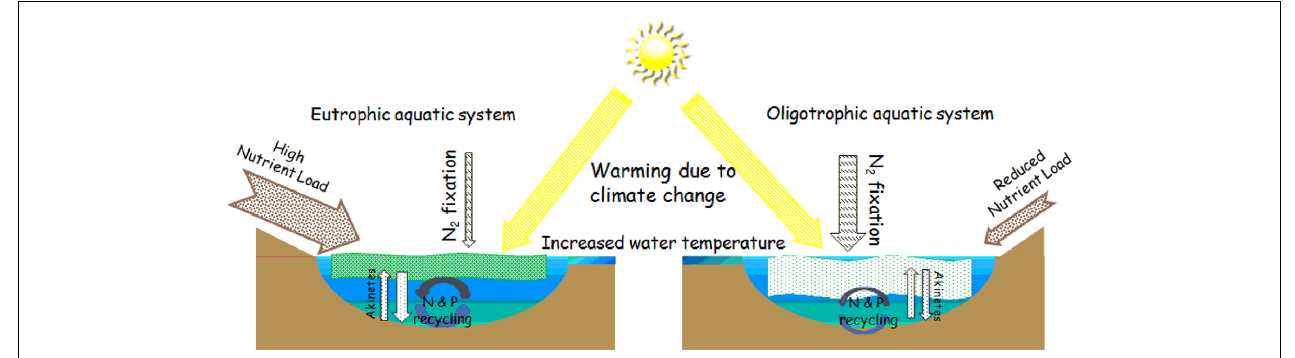
formation and N 2 fixation and is controlled by restricted external and internal P load (narrow arrows). Dormant cells, akinetes, are formed in both cases (more akinetes are expected in eutrophic systems due to high biomass content) and provide the basis for perennial blooms. Note that nutrient recycling from bottom sediments occur in both systems but is more essential source for N and P in oligotrophic system. Nitrogen fixation is also evident in eutrophic systems only when the ample inorganic N provided by external and internal sources is